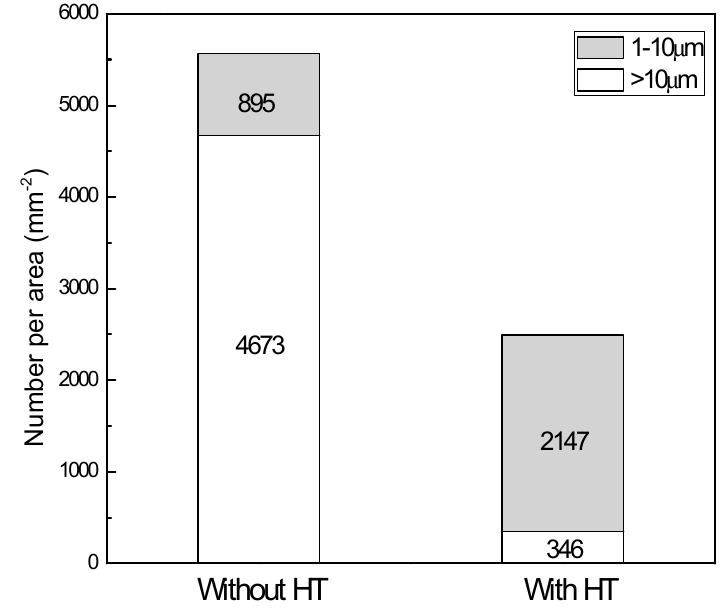
Figure 5. Particle-size distribution and number per area for ECAPed Mg-9Al-1Si-1SiC composites.